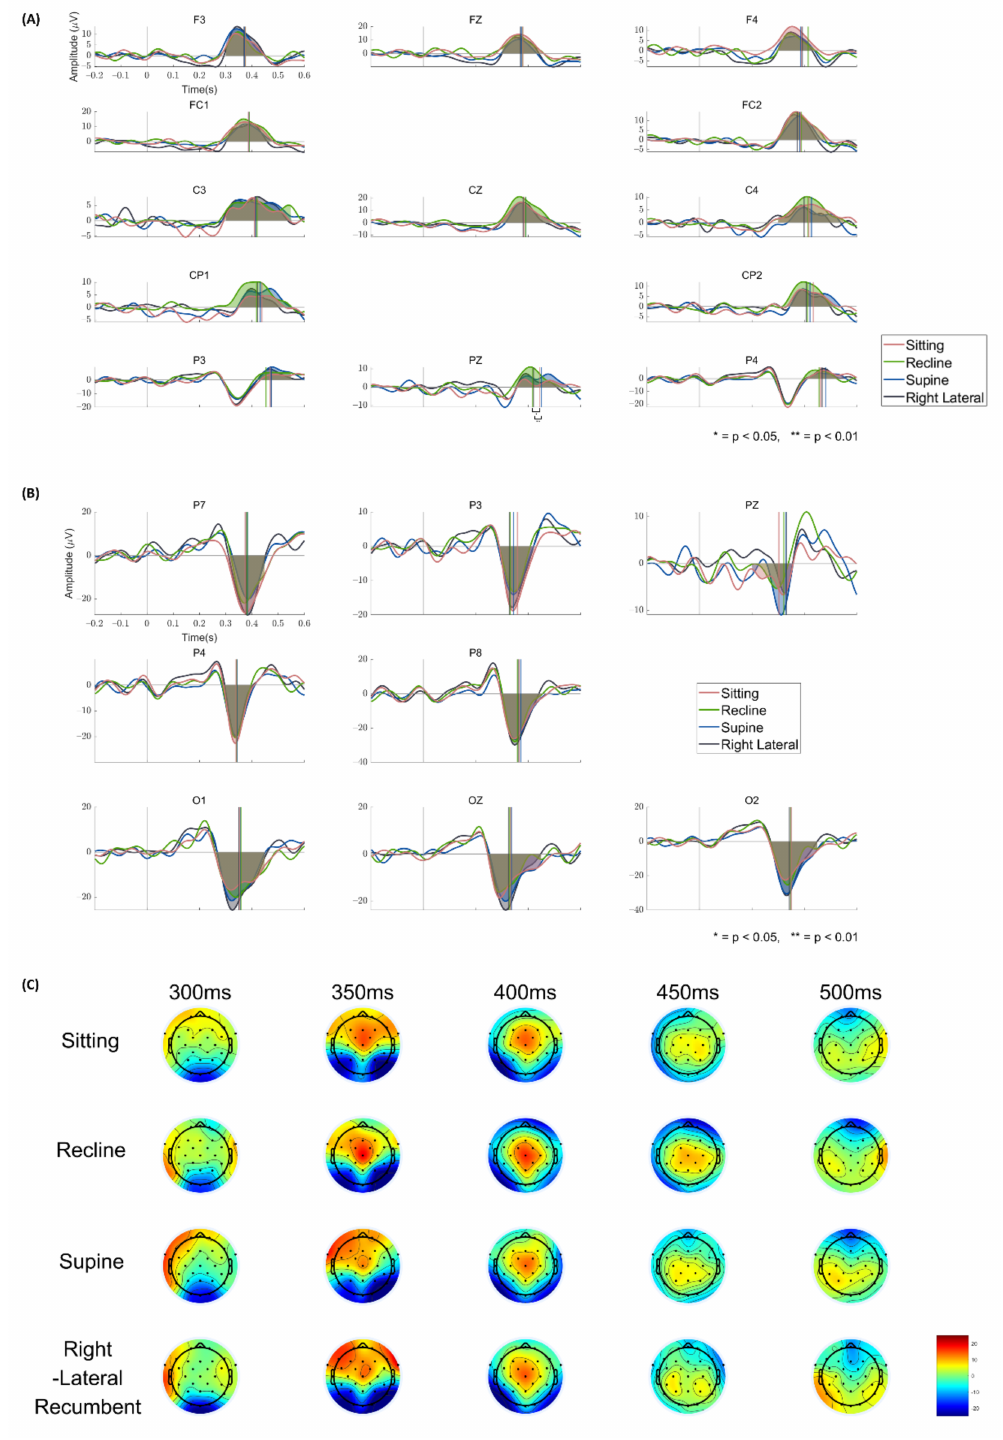
Figure 4. The grand averaged ERP graph for each posture. The red, green, blue, and black line indicates the ERPs for the sitting, recline, supine, and right lateral recumbent posture, respectively. The vertical lines denote the 50% area latency for each component. ( A ) The grand averaged ERP at electrodes where the P300 component appears. The shaded area represents the positive area of the ERP waveform between 300 to 550 ms after the stimulus onset. ( B ) The grand averaged ERP at electrodes where the N200 appears. The shaded area indicates the negative area of the ERP waveform between 200 to 450 ms after the stimulus onset. * p < 0.05, ** p < 0.01. ( C ) The topoplot for each posture in time 300, 350, 400, 450, and 500 ms. The color indicates the amplitude ( µ